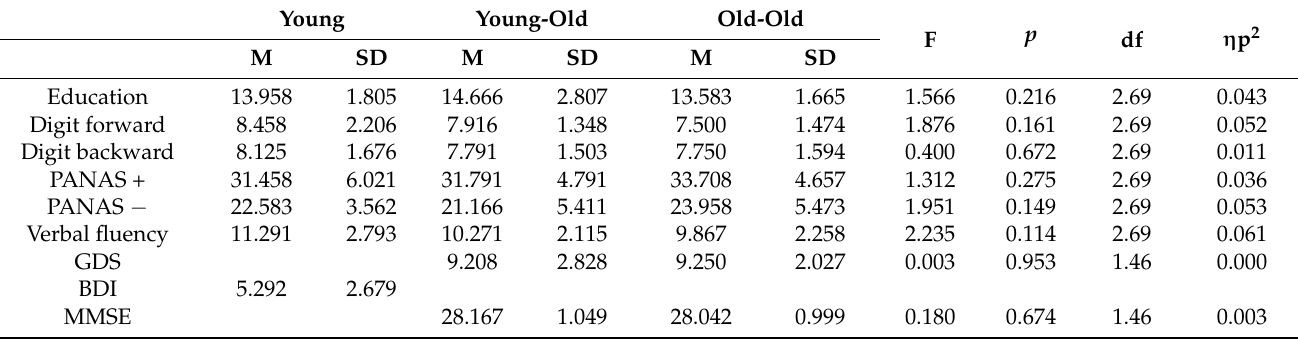
Table 1. Demographics and control